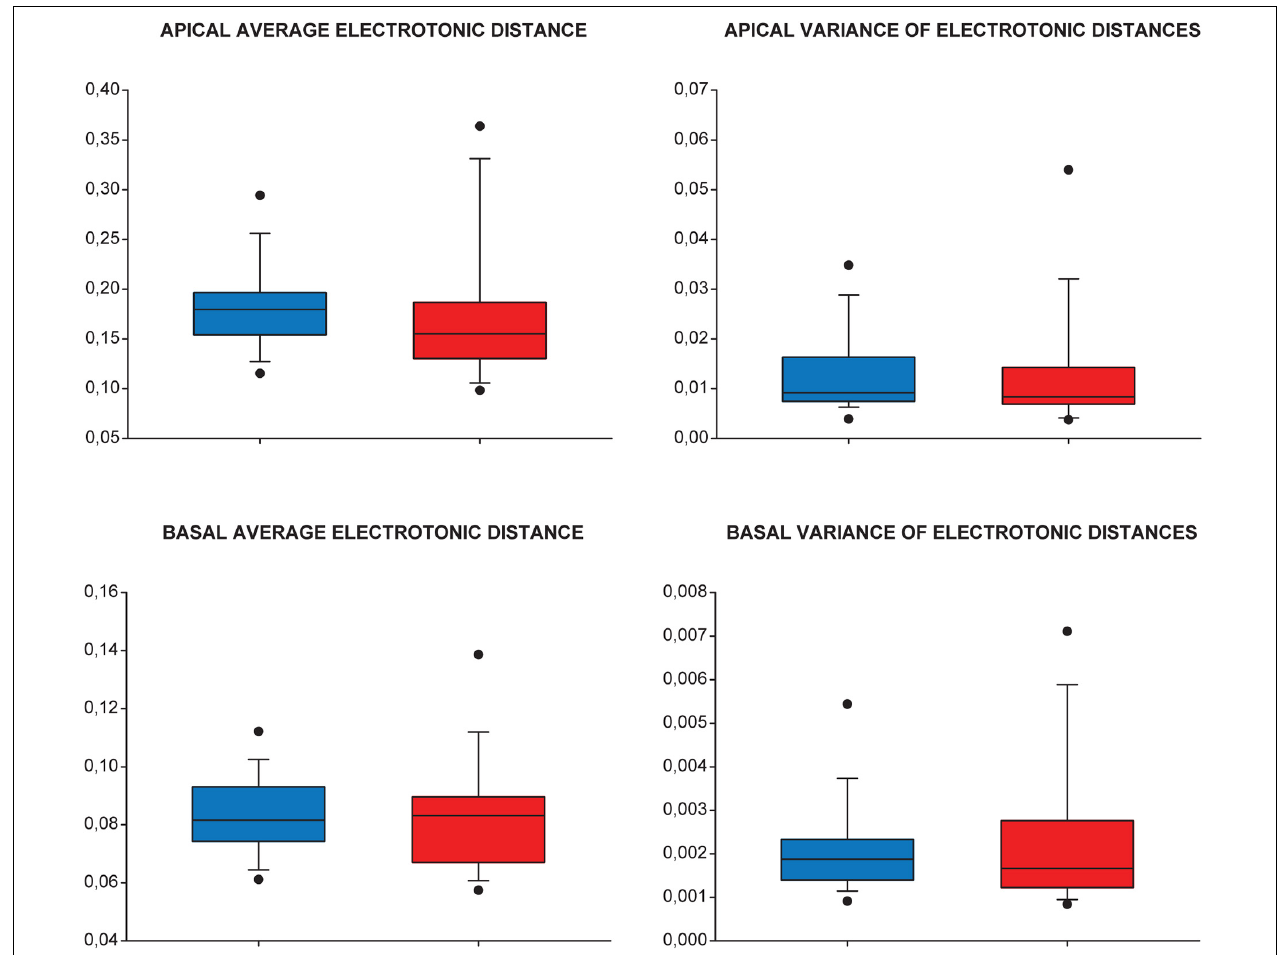
FIGURE 12 | Synaptic input pattern recognition/discrimination is unchanged in advanced tauopathy. Means and variances of electronic distances of modeled dendritic synapses (injection sites) from the cell body were used to quantify and compare levels of synaptic input pattern recognition/discrimination capabilities in WT (blue), TG (red) neurons. Apical (upper panels) and basal (lower panels) dendritic arbors were analyzed separately. Lower and upper boundaries of the boxes indicate the 25th and 75th percentiles; a line within each box marks the median value; whiskers below and above the boxes show the 10th and 90th percentiles; lower and upper closed circles represent the 5th and 95th percentiles. Statistical analysis showed no significant (ns.) alteration in the predictors of synaptic input pattern recognition/discrimination capabilities of TG neurons (Mann–Whitney test, p > 0.161, p > 0.46, p > 0.68, and p > 0.93 for apical average and variance and basal average and variance of electrotonic distances,